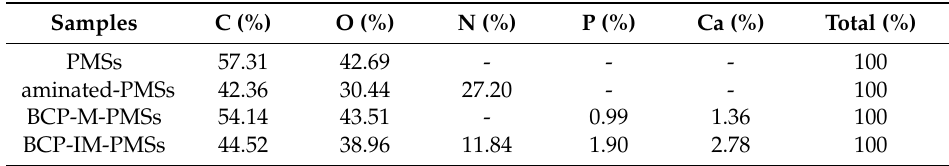
Table 2. Surface elemental compositions of PMSs, aminated PMSs, BCP-M-PMSs, and BCP-IM-PMSs. Samples